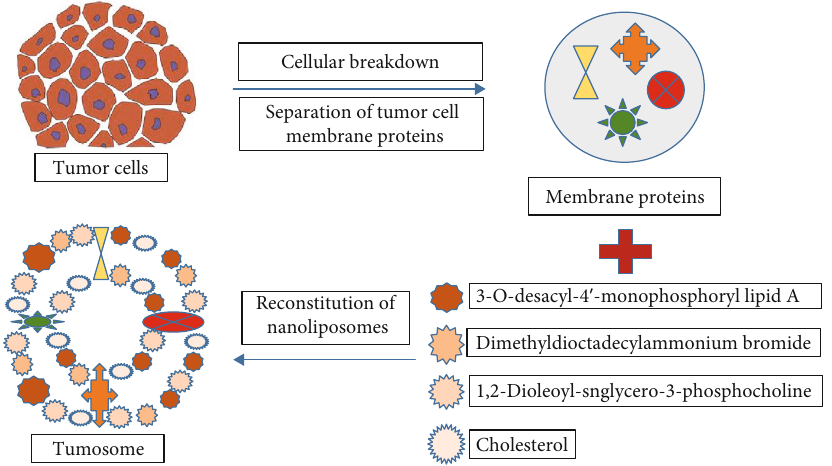
Figure 5: Diagrammatic presentation of multifaceted tumosome for cancer immunotherapy.